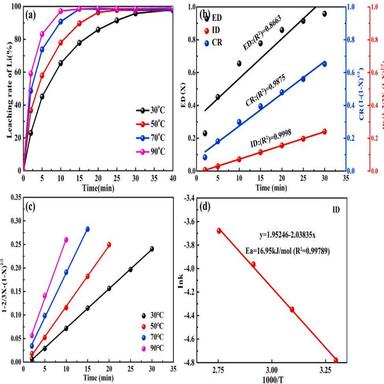
(a) The leaching rate of Li at different temperature and time, (b) data fitting diagrams of different leaching models at 30 ◦C, (c) data fitting diagram of internal diffusion model at different temperature, (d) lnk-1000/T diagram of internal diffusion.